Question: Provide a one-line summary of what is displayed.
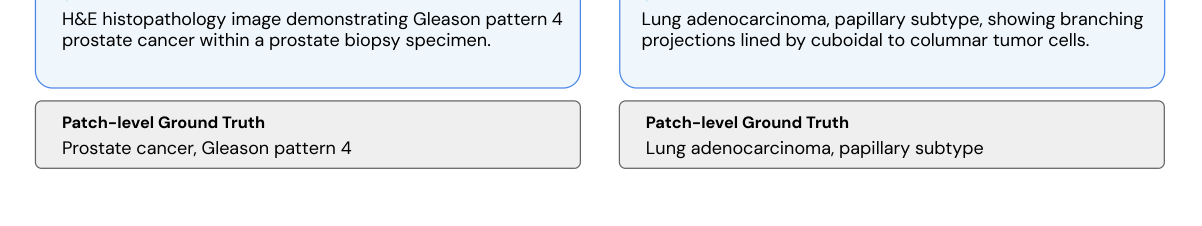
Answer: | Examples of histopathology image-based dialogue. These examples highlight accurate histopathol- ogy interpretation and communication of information across a range of tissues and findings with only a small amount of visual context. While there is some promising initial evidence for ability to interact and reason further about images (top right), current capabilities for follow up interaction and exploration of input images are limited and this remains an active area for improvement. This demonstration utilizes histopathology patches from TCGA, CAMELYON16, and other data sources as described in Lai et al. (2023).